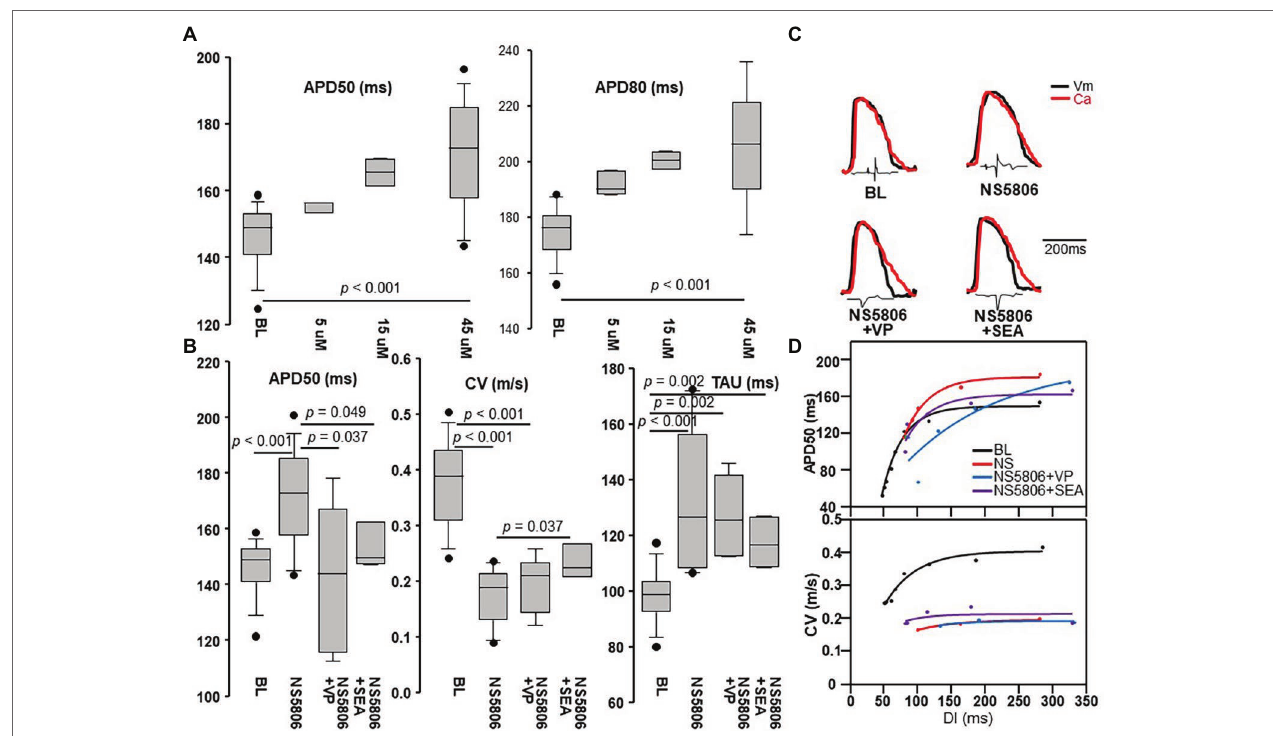
FIGURE 2 | Effects of NS5806 and additional drugs on action potential (AP) and Ca transient dynamics. (A) APD50 (at 50% of repolarization) and APD80 at BL, 5, 15, and 45 μ M of NS5806. At 45 μ M, both APD50 and APD80 were prolonged. (B) APD50, conduction velocity (CV), and Ca exponential decay (TAU) during pacing at 3 Hz in different conditions. NS5806 significantly increased APD50, reduced CV, and increased TAU. NS5806 + SEA significantly reduced APD50 and increased CV compared to NS5806. NS5806 + VP reduced APD50 compared to NS5806. n = 20 animals in BL and NS5806 group, n = 5 animals in NS5806 + VP and NS5806 + SEA group. Box = 25th and 75th percentiles. Bars = minimum and maximum values. Dots = outliers. p < 0.05 was considered statistically significant. (C) Superimposed AP and Ca tracings during pacing at 3 Hz in different conditions. (D) APD50 and CV restitution in different conditions. NS5806 reached longer range of DI with an APD restitution slope > 1. NS5806 failed to maintain 1:1 capture at shorter DIs. NS5806 dropped CV by half and led to a nearly flat CV restitution curve. DI, Diastolic interval. Other abbre via tions as in Figure 1